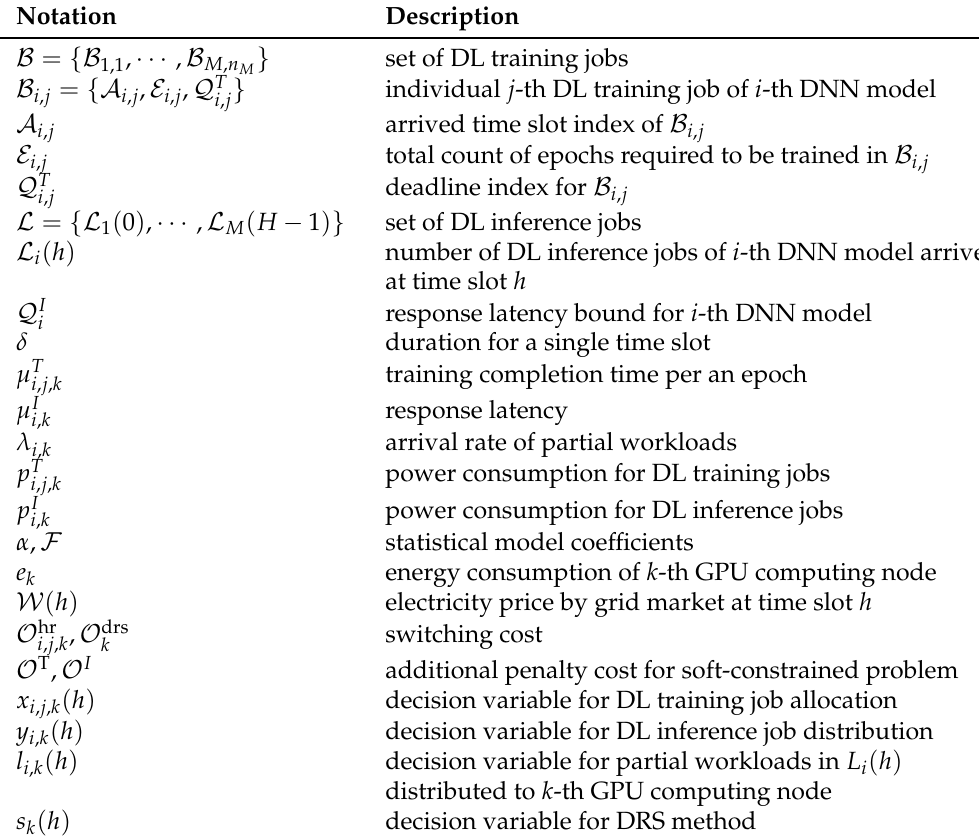
Table 1. Notations used in